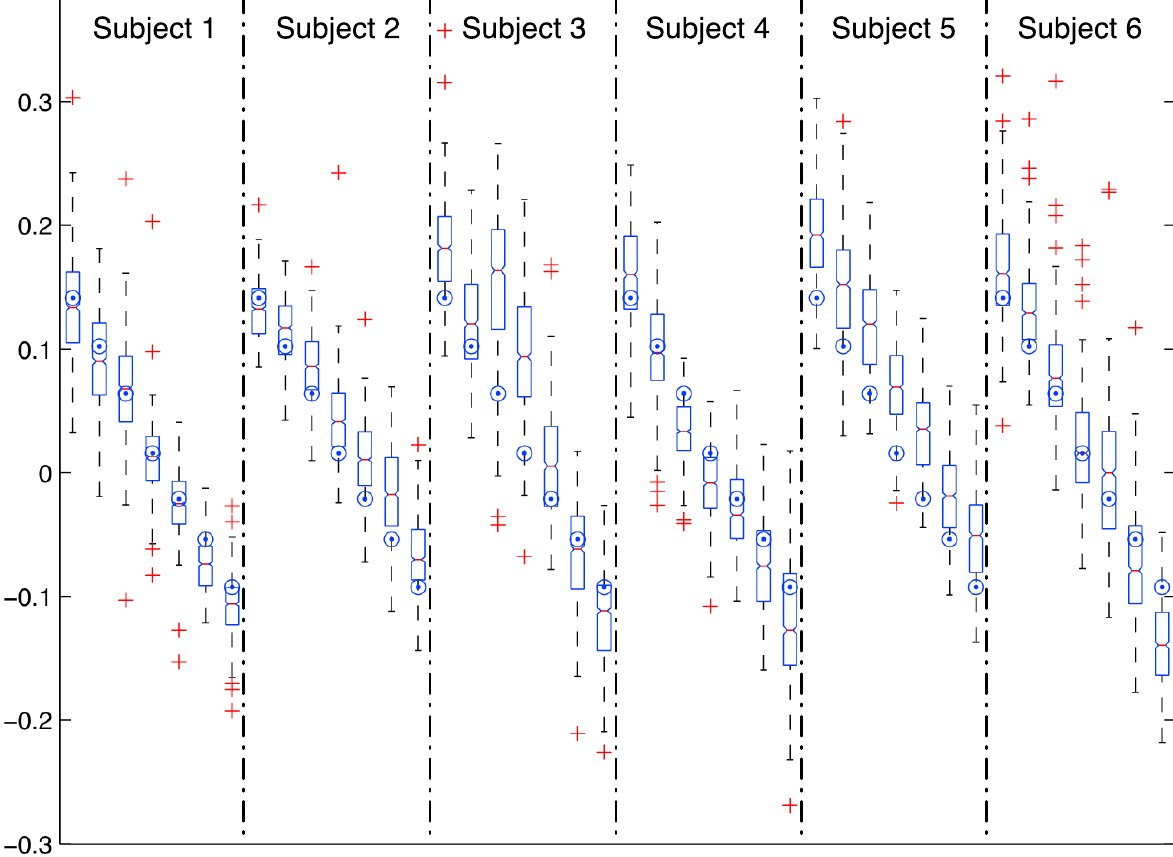
stands for Subject n. n